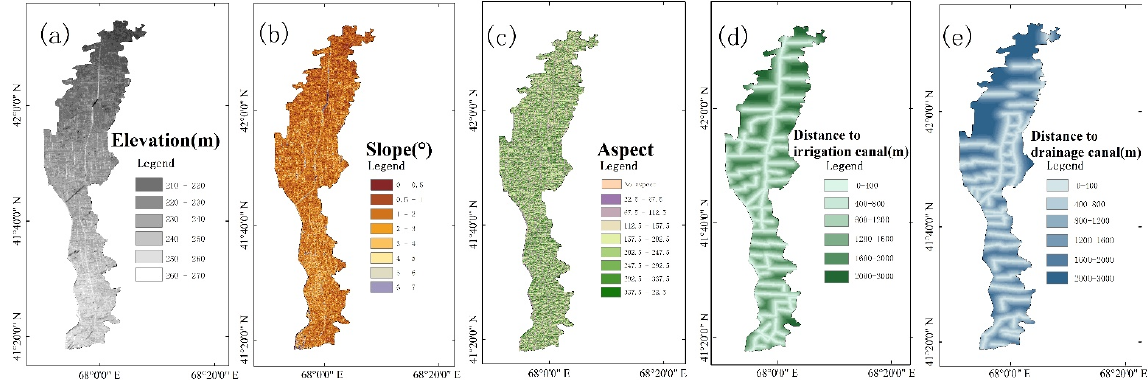
Figure 7. Spatial distribution of factors influencing soil salinity in the Shardara district: ( a ) elevation; ( b ) slope; ( c ) aspect; ( d ) distance to drainage canal; and ( e ) distance to irrigation canal.